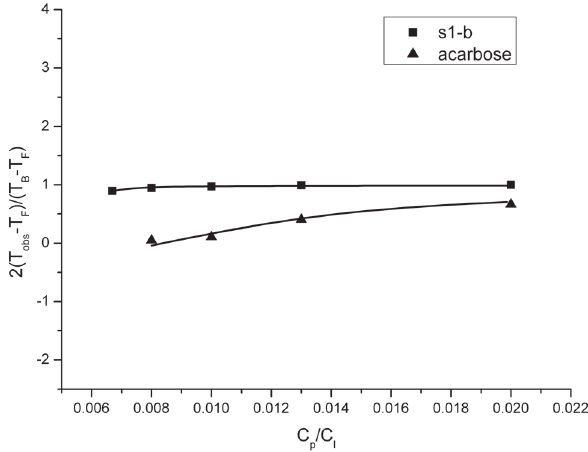
Figure 3. Plots of the measured relaxation time as a function of the concentration ratio Cp/Cl for the S1-b/ntMGAM system and acarbose/ntMGAM system. Solid curves are the calculated results using Eq. (2).